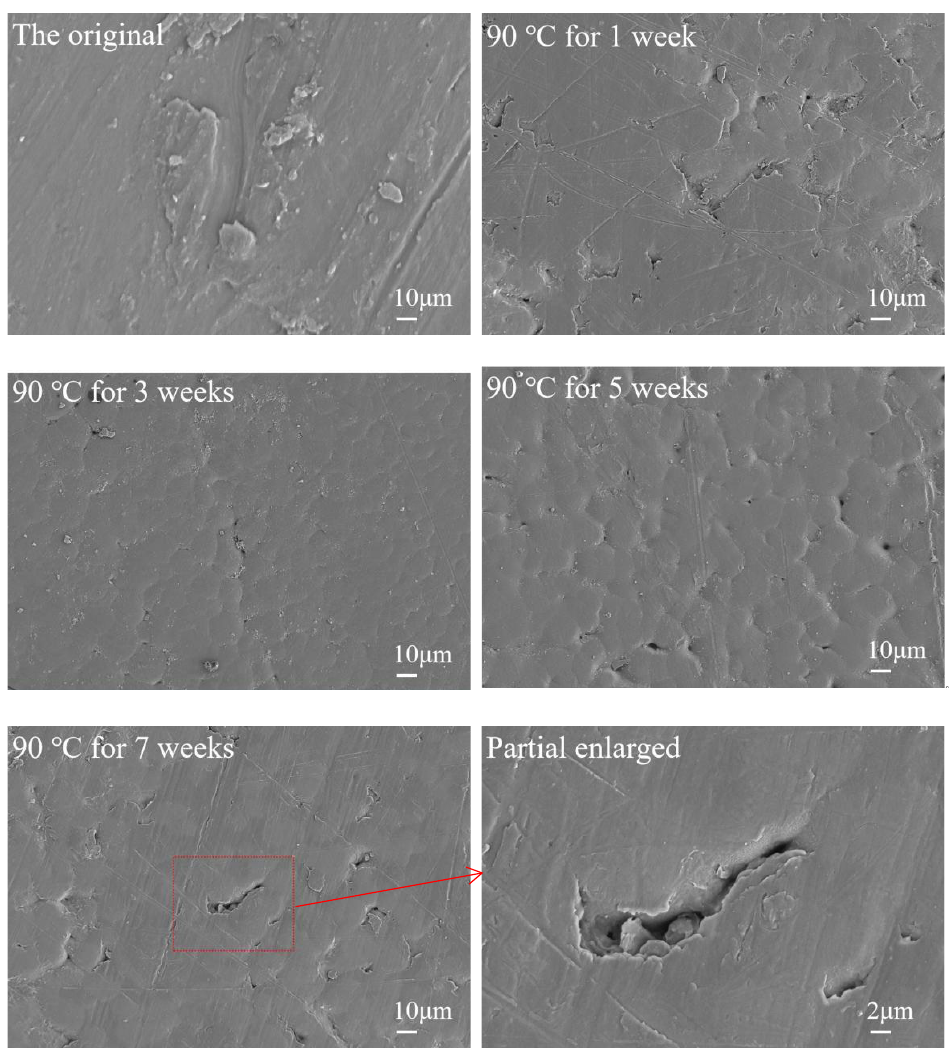
Figure 9. The SEM micrographs of PVDF.